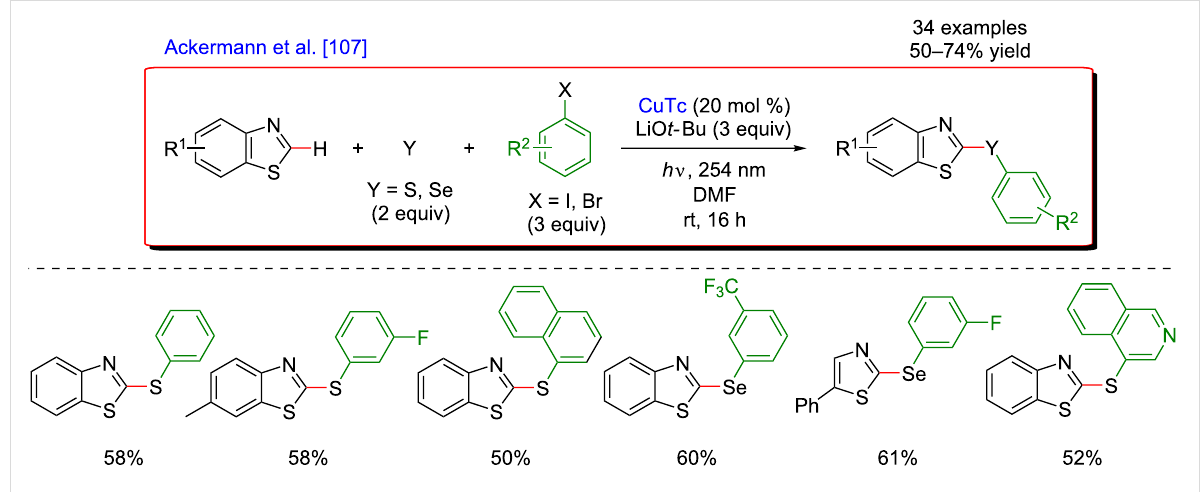
Figure 47: Photo-induced C–H chalcogenation of azoles via copper